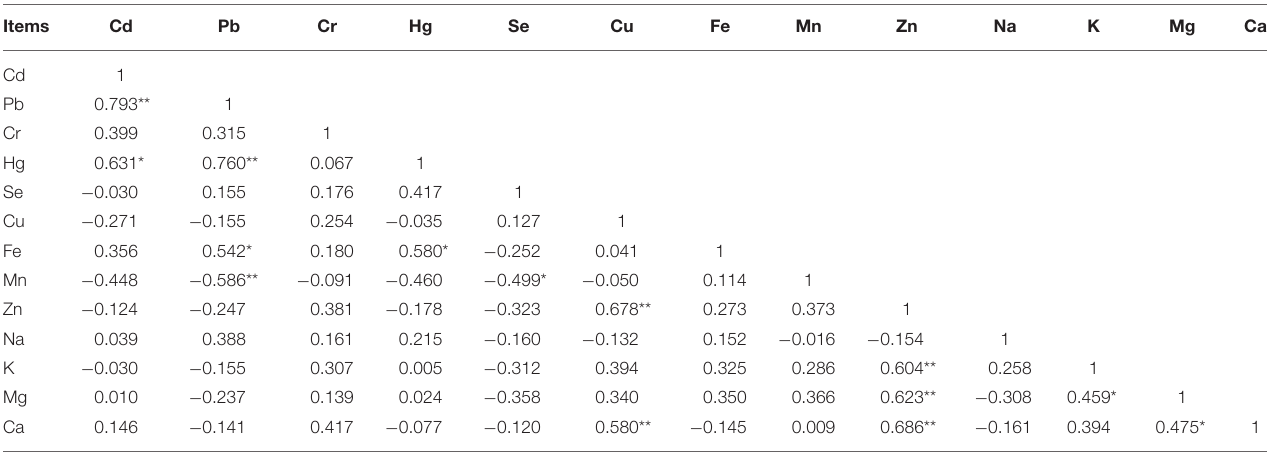
TABLE 6 | Correlation between the concentrations of ions in the Follicle walls. Items